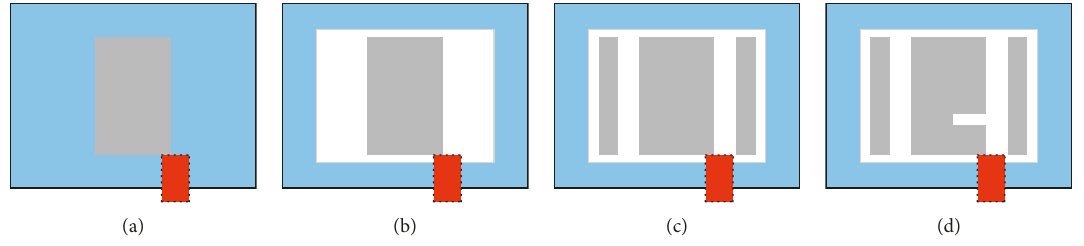
Figure 2: Steps to realize the proposed antenna. (a) ANT.1. (b) ANT 2. (c) ANT.3. (d) ANT.4.